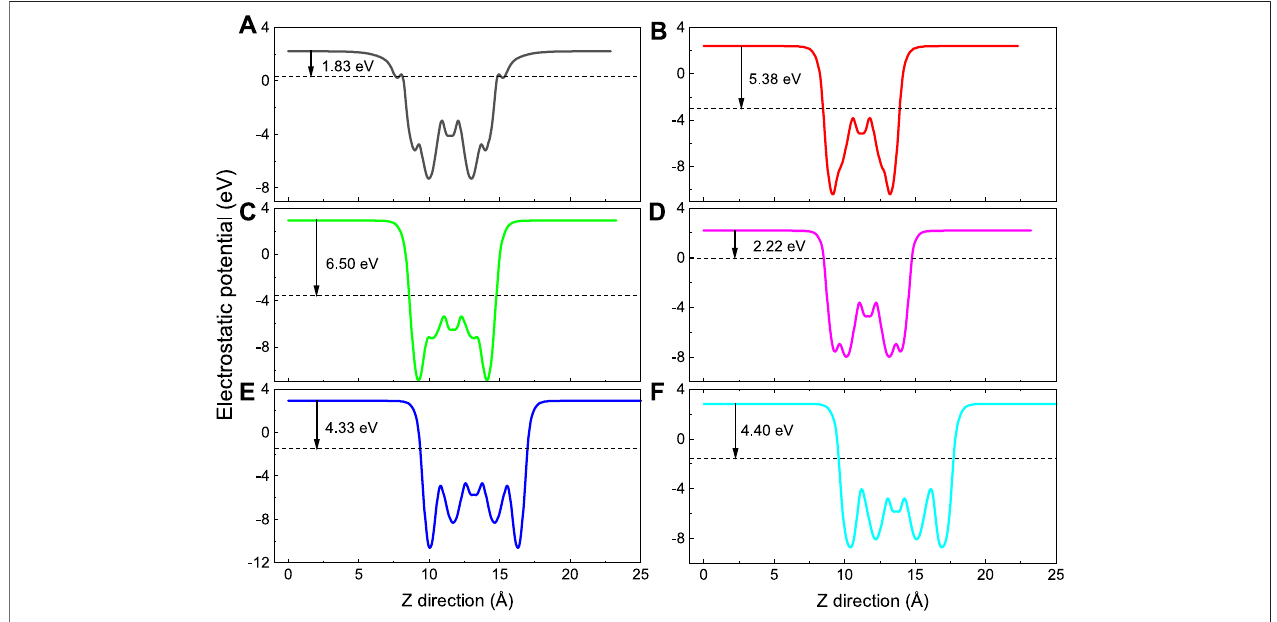
FIGURE 5 | Calculated electrostatic potentials along the Z direction of Nd 2 NT 2 (T = OH, O, S, F, Cl, and Br), while (A) Nd 2 N(OH) 2 , (B) Nd 2 NO 2 , (C) Nd 2 NS 2 , (D) Nd